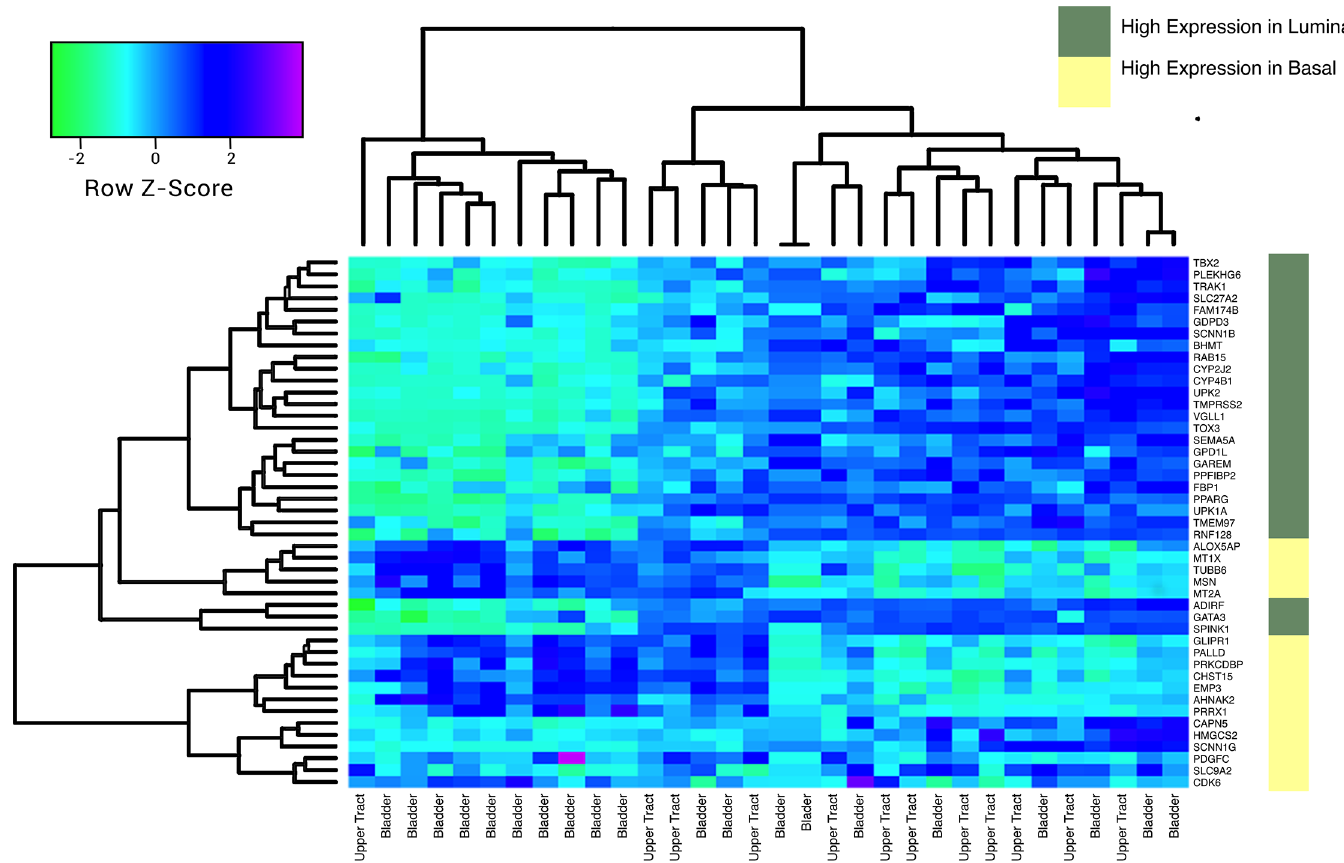
Fig 4. Heatmap of BASE47 gene signature with high expression of luminal type markers in UTUC.